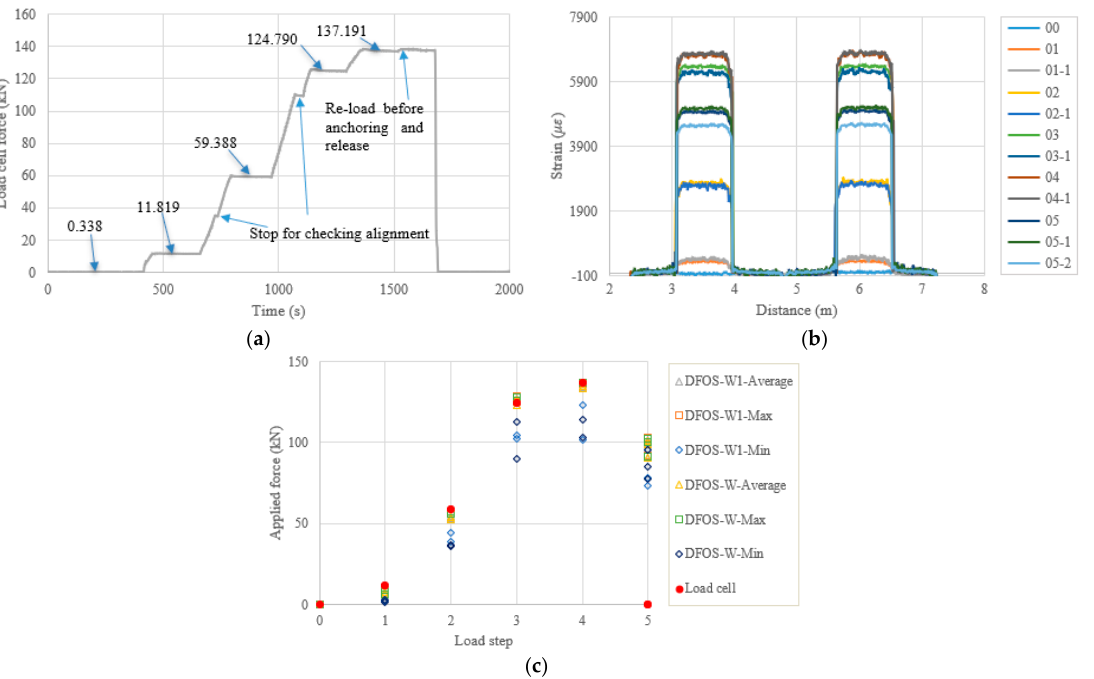
Figure 14. ( a ) Load cell readings for PC4-2; ( b ) strain distribution along the strand (W1 and W fibers) (In the legend, the first number represents the load step, and the second number represents measurement times at the load step); and ( c ) applied force changes at different load steps. Table 11. Prestressing force monitored by load cell and DFOSs for PC4-2 (unit: kN).